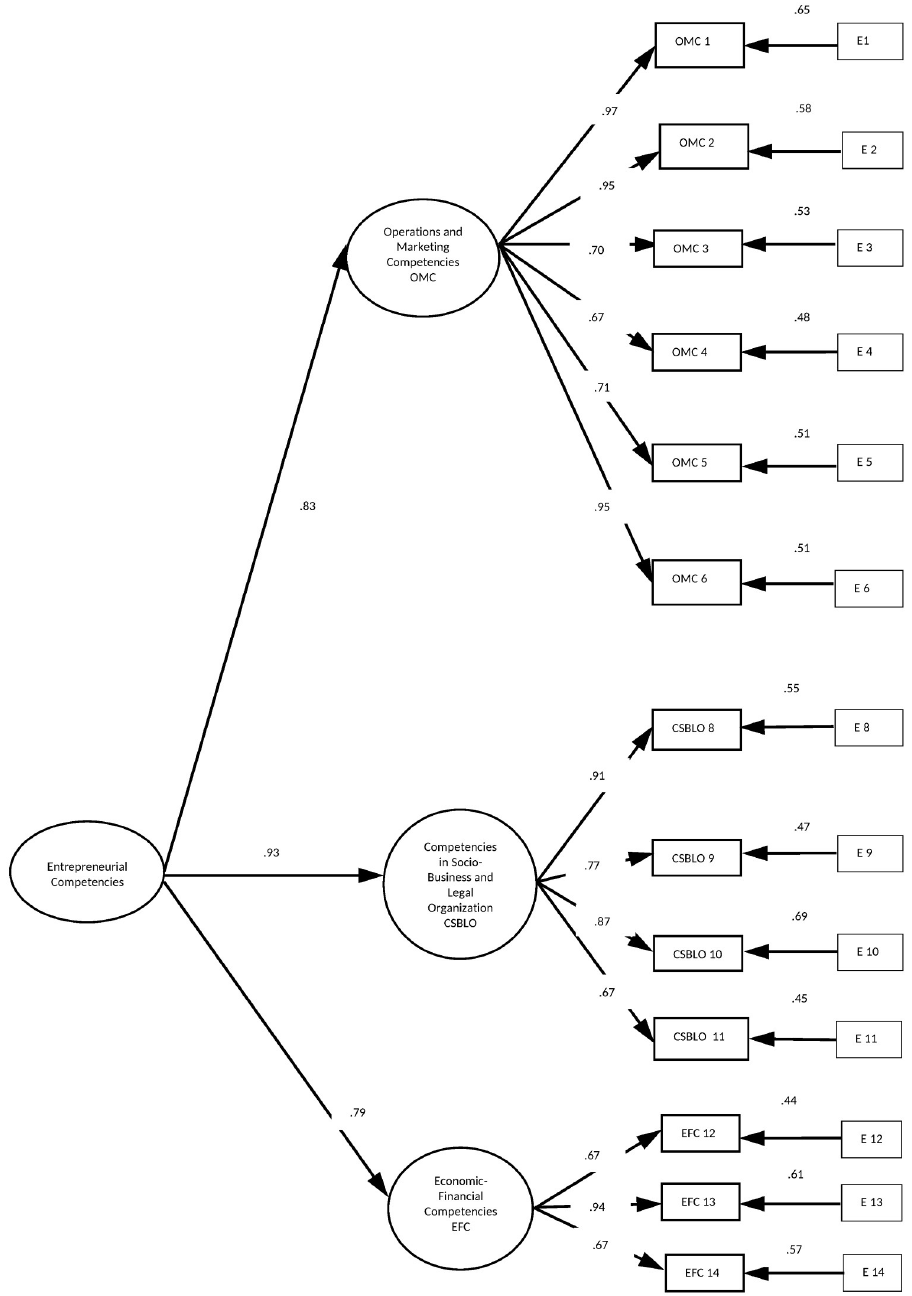
Fig 2. Metric model of the BSEC by CFA. Sample of 720 and standardized solution, p < .0001.